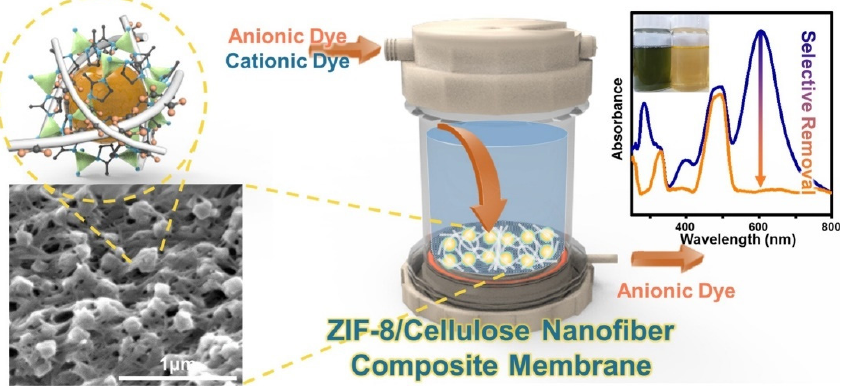
Figure 9. A 21 wt.% ZIF–8 loaded 2,2,6,6-tetramethylpiperidine 1-oxyl radical oxidized